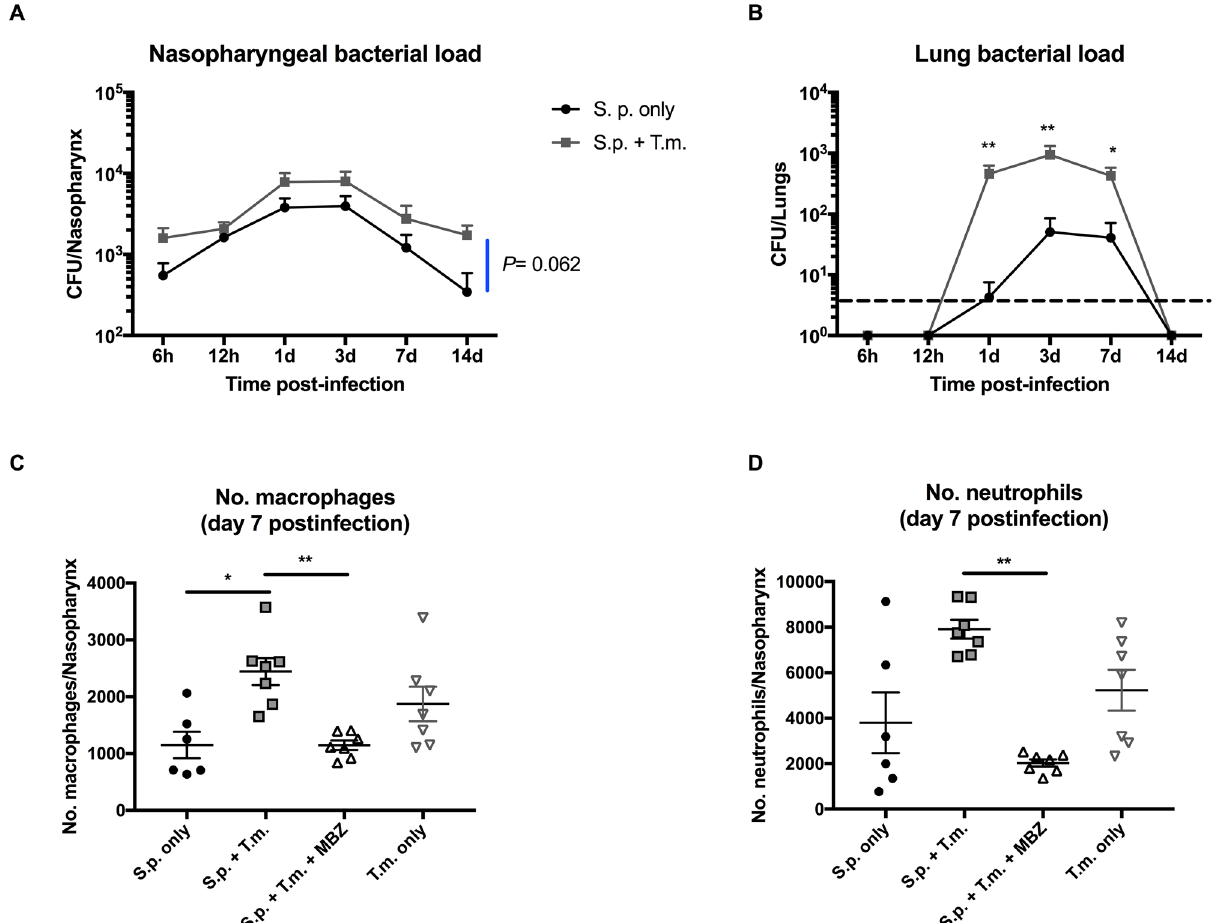
Figure 1. Effects of intestinal helminth co-infection and anthelmintic treatment on pneumococcal infection dynamics and host immune responses. Mice were infected with 20 T . muris eggs by oral gavage, followed by induction of pneumococcal carriage 28 days later. Co-infected mice had a trend towards increased nasopharyngeal carriage density as compared to pneumococcus only infected animals ( A ) and this was accompanied by significantly increased pneumococcal dissemination into lungs of co-infected animals ( B ). Co-infection was accompanied by increased macrophages ( C ) and neutrophils ( D ), which was reversed